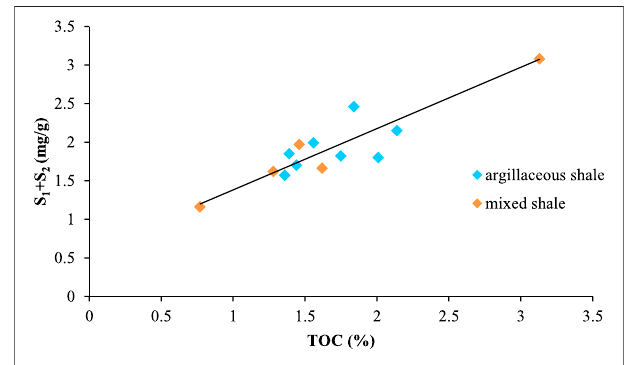
FIGURE 4 | Intersection diagram of TOC and hydrocarbon generation potential.